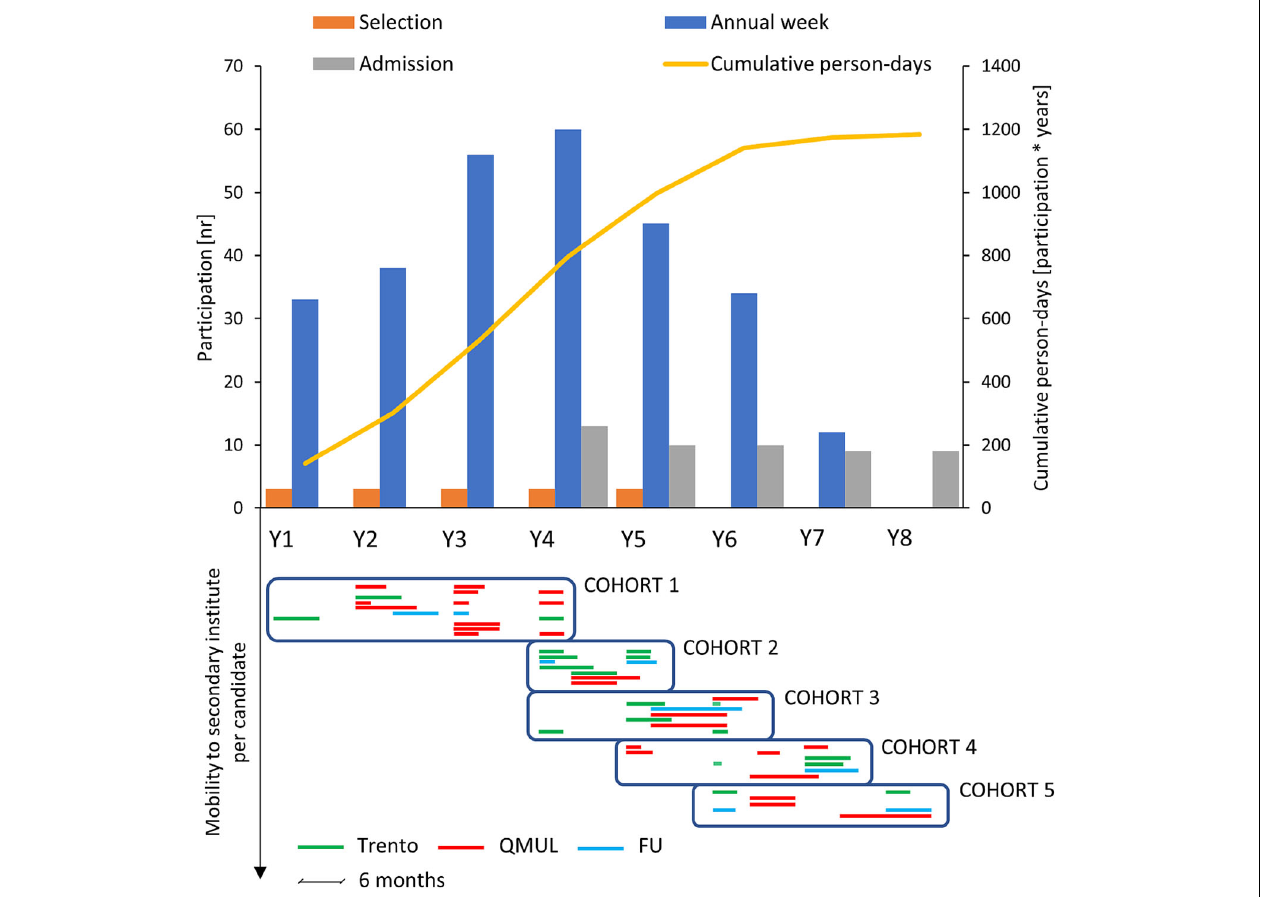
FIGURE 8 | On top: Participation for each meeting event (selection, annual week, and admission) and cumulative days of these meetings. Below: Overview of secondary mobility over time of all doctoral candidates with color indicating the